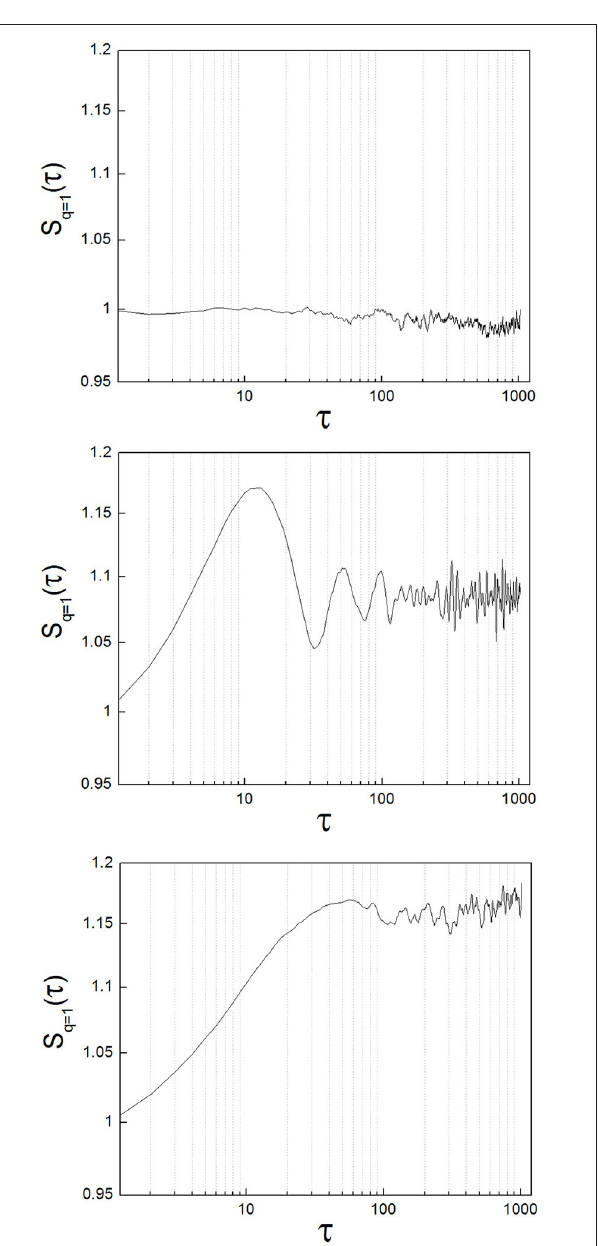
FIGURE 4 | Different types of structure functions from neuronal recordings show features of random, oscillatory, and nonlinear systems. (Upper) Sample neuron with a structure function showing zero-slope at all scales, indicating random behavior. (Middle) Sample neuron with a structure function showing oscillations. (Lower) This case is the most representative of all the neurons analyzed (64%). The structure function has clear, nonlinear behavior.